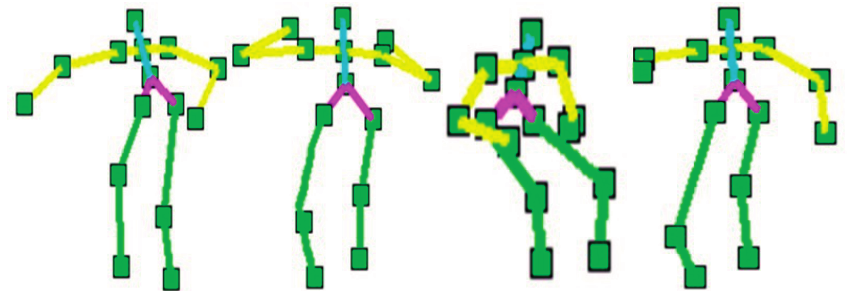
Figure 4. The body joint points of different human